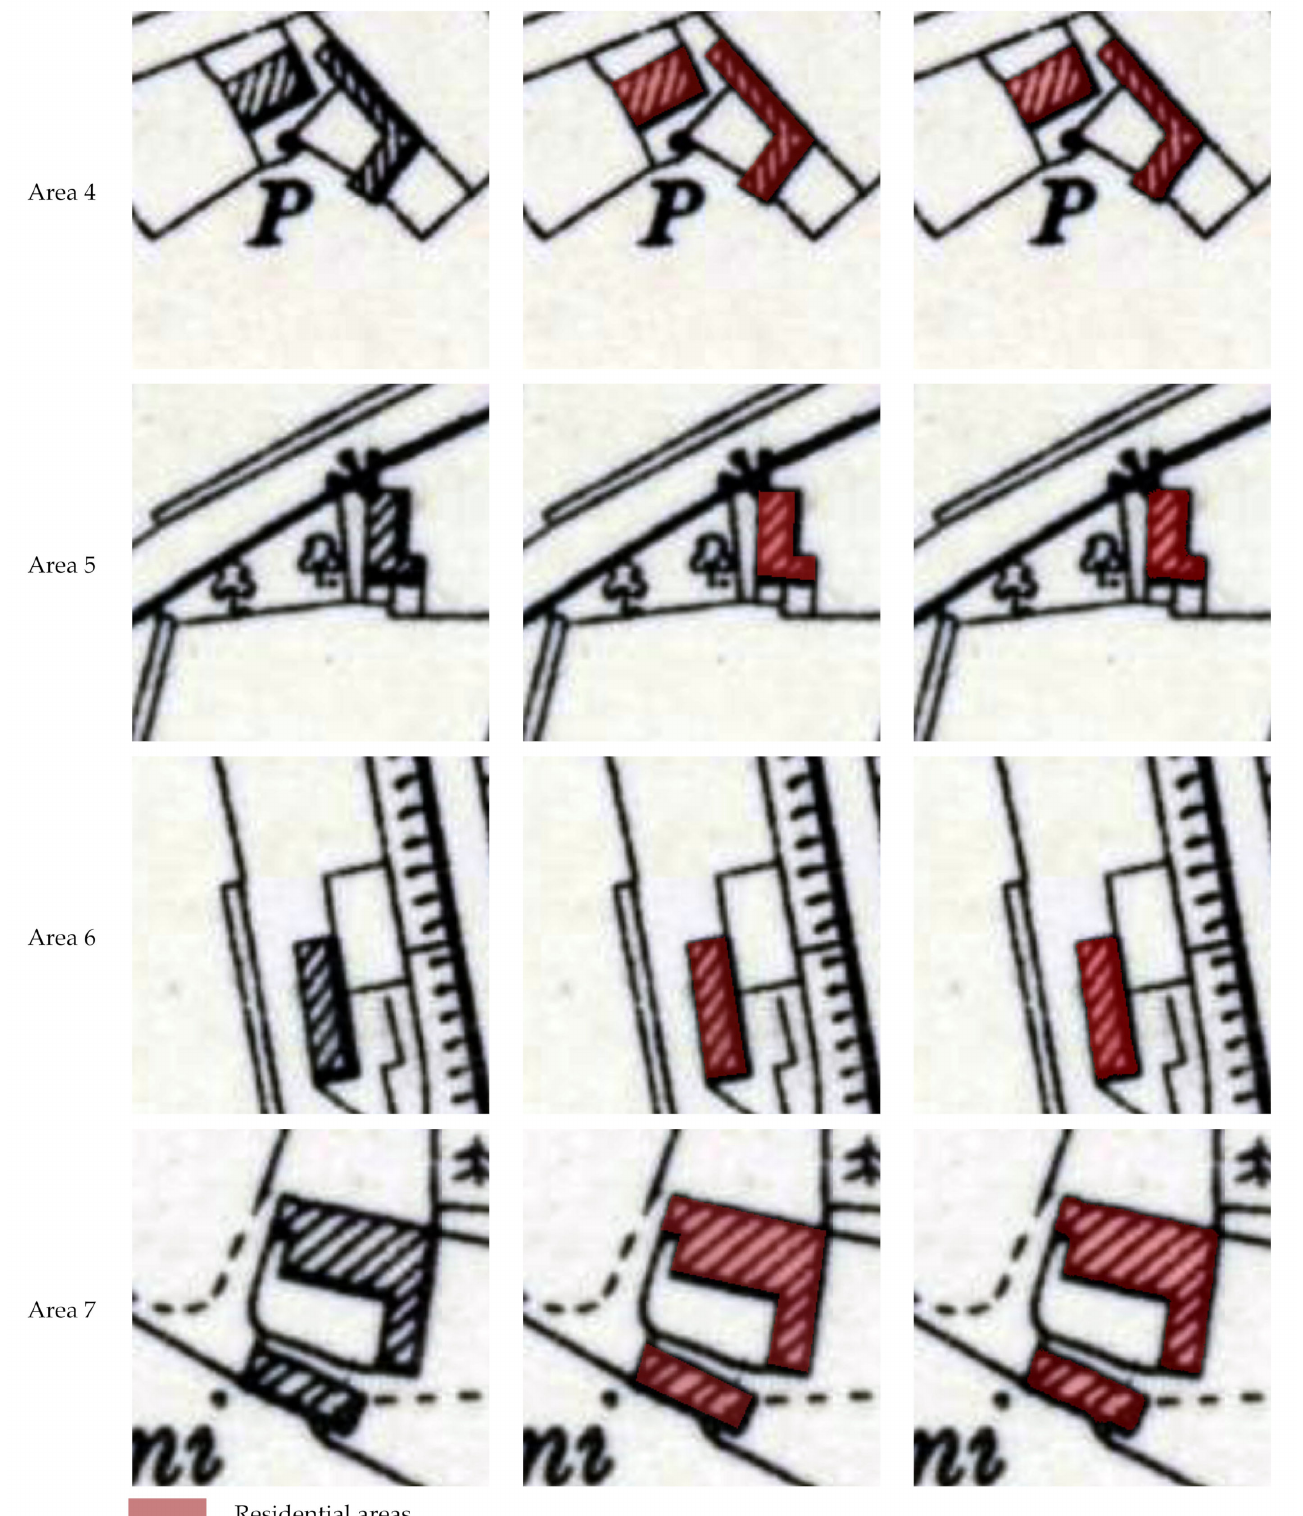
Figure 7. AEHRA-based extraction results of hatched residential